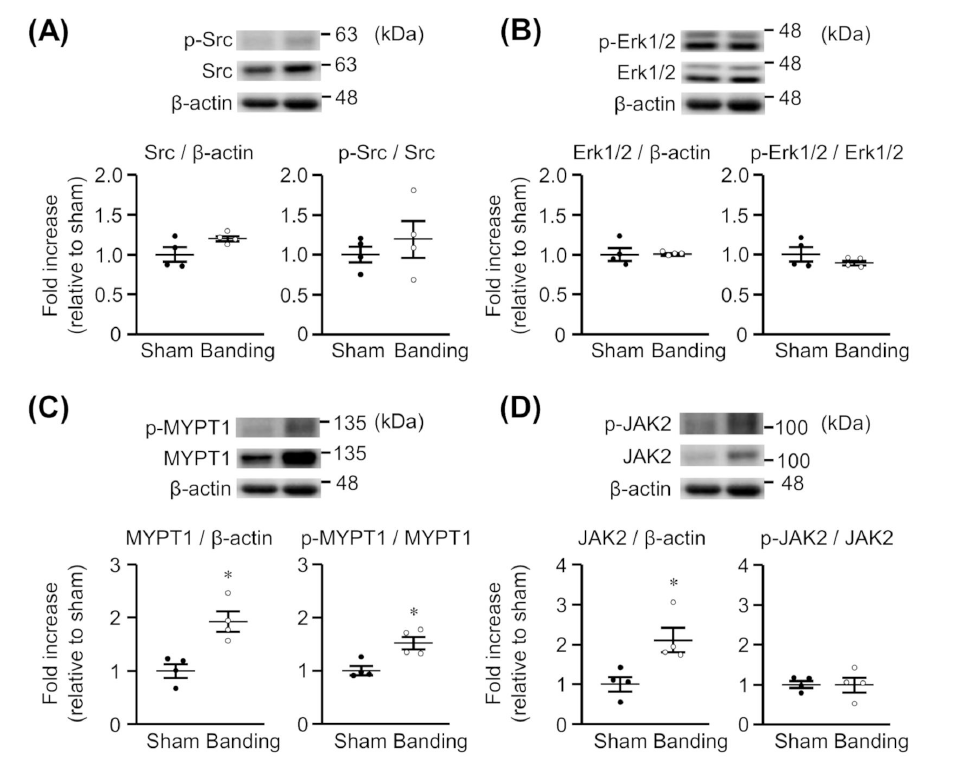
Figure 2. Expression of total and phosphorylated Src ( A ), Erk1/2 ( B ), MYPT1 ( C ), and JAK2 ( D ) in thoracic aortas from sham-operated (Sham) or pressure-overloaded (Banding) rats. Upper: rep- resentative blots. Lower: scatter plots demonstrating densitometric quantification of the ratios of total or phosphorylated proteins to the corresponding β -actin or total proteins, respectively. Results are shown as the fold increase relative to Sham. Data are means ± S.E.M. of four independent experiments, * p < 0.05 vs.